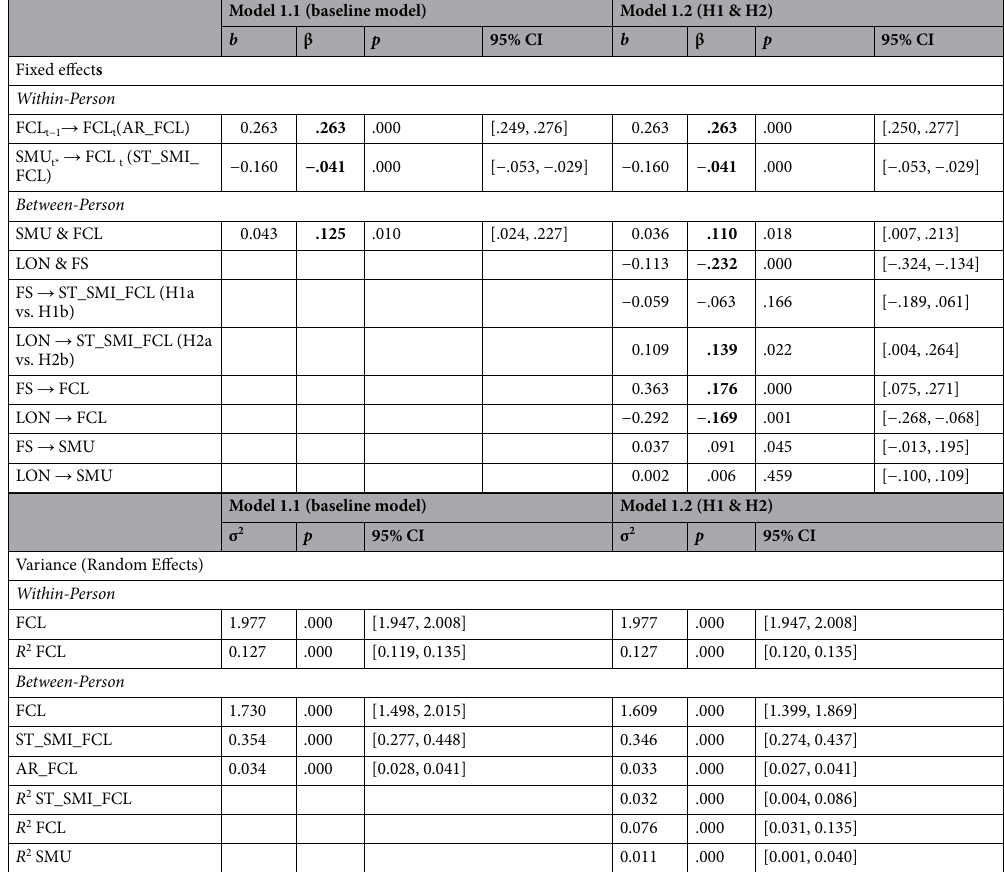
Table 2. DSEM results of the short-term effects of social media use with friends (SMU) on friendship closeness (FCL) based on the ESM assesments. Social media use (SMU) was dummy coded (i.e., 0 = no